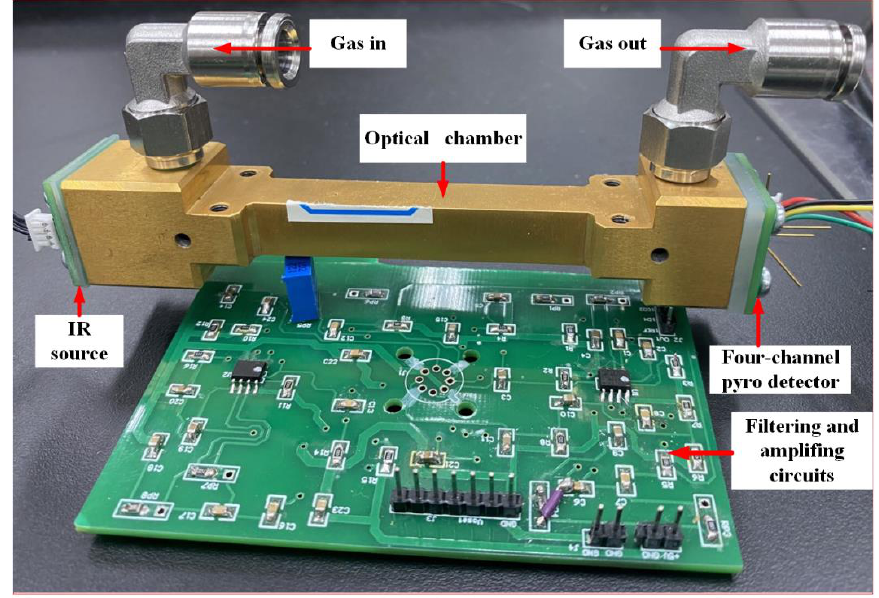
Figure 3. The test system diagram used for multi-gas detection.